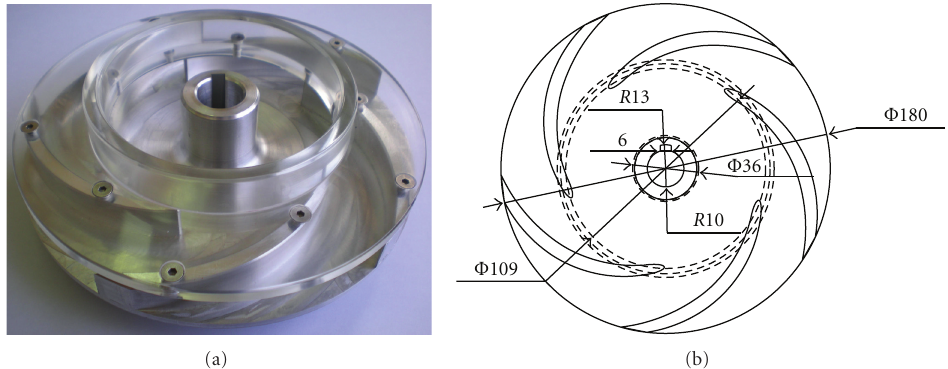
Figure 4: The examined impeller geometry and the scaled drawing (in mm) with blade leading edge angle of 15deg.